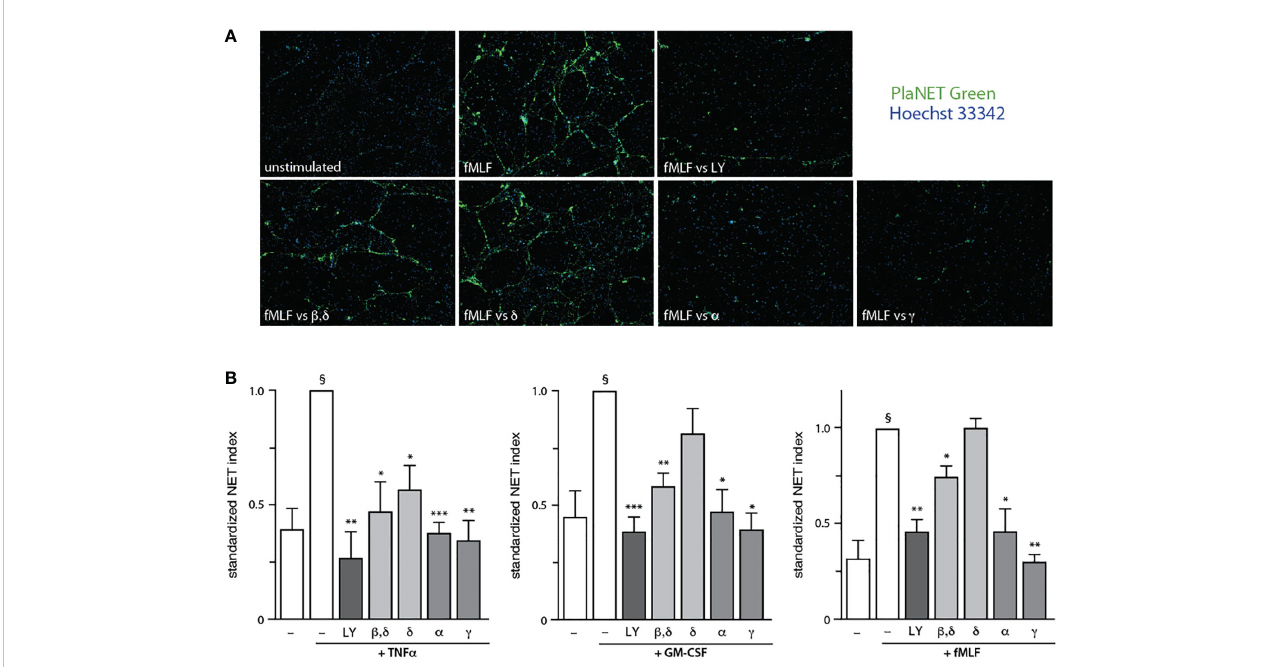
FIGURE 1 Stimulus-dependent involvement of discrete PI3K isoforms in NET formation. Neutrophils cultured at 37°C on poly-L-lysine-coated coverslips were pre- treated (15 min) with the following PI3K isoform-selective inhibitors or their diluent (0.1% DMSO): 10 m M LY294002 (a general PI3K inhibitor, “ LY ” ); 1 m M TGX-221 ( b , d ); 1 m M IC87114 ( d ); 1 m M PI3K a inhibitor IV ( a ); 1 m M AS64002 ( g ). The cells were then stimulated or not for 4 h at 37°C with 100 U/ml TNF a , 1 nM GM-CSF, or 100 nM fMLF. NET formation was assessed using PlaNET Green as described in Methods . (A) A representative experiment is shown (10X magni fi cation) for fMLF-treated cells. (B) Mean ± s.e.m. of the standardized NET index from at least 4 independent experiments. *, p<0.05; **, p<0.01; ***, p<0.001 vs stimulus alone. §, p < 0.02 for unstimulated cells vs stimulus.